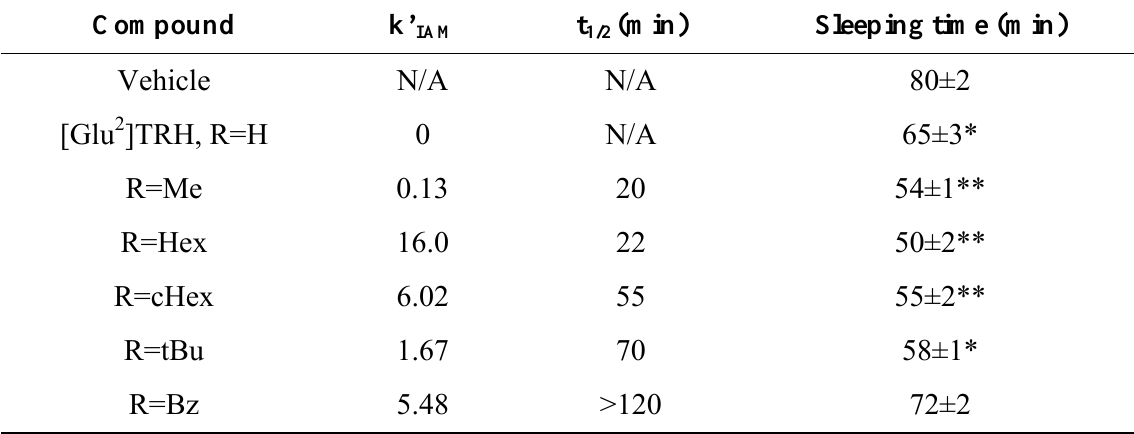
), in vitro half-lives (in 20% w/v mouse brain Table 2 . IAMC capacity factors (k’ IAM homogenate) and analeptic effects of test compounds (i.v. in mice at equimolar dose of 10 μ mol/kg body weight when pentobarbital (i.p., 60 mg/kg body weight) was administered 10 min after the injection of the saline vehicle or test compounds) [55]. The k’ -t )/t , where t is the retention time for the compound and t was calculated as (t R 0 0 R retention time of [Glu 2 ]TRH used as a marker for dead volume. Statistically